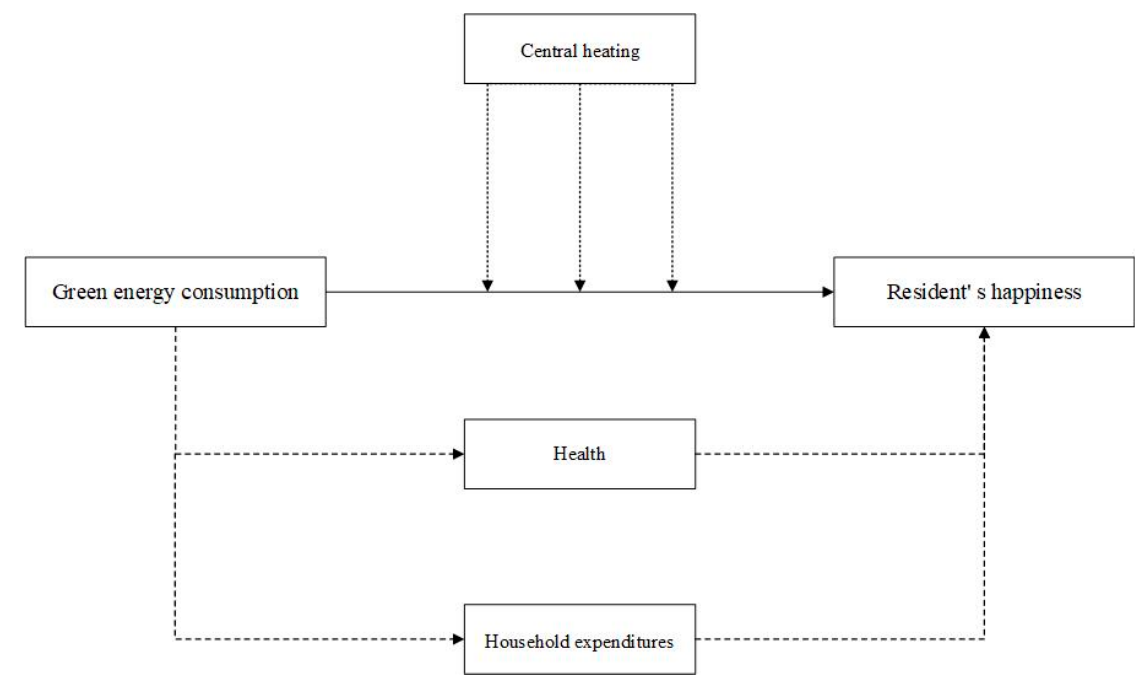
Figure 4. The mechanism of clean energy consumption revolution effect on resident’ happiness.